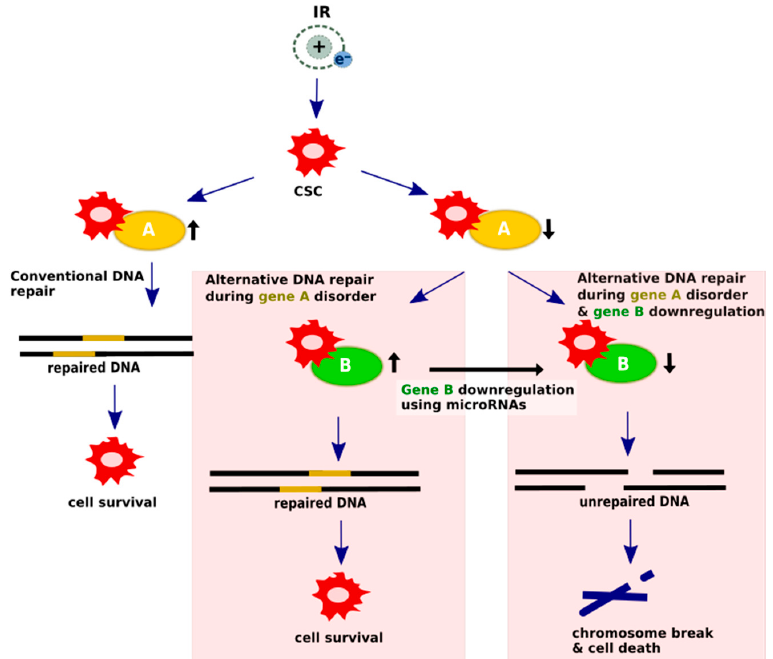
Figure 3. Synthetic lethality mechanism undergoes microRNA regulation. In conventional pathways, DSBs are repaired and cells are able to survive; however, cells with DNA-repair protein deficiencies rely heavily on alternative mechanisms to repair damaged DNA. The concept of alternative DNA repair pathways using microRNA modulation assumes that silencing a crucial gene factor provides chromosome discontinuity and cell death. Upregulated DNA damage repair genes are assigned as black arrows pointing up, while suppressed genes are presented as black arrows pointing